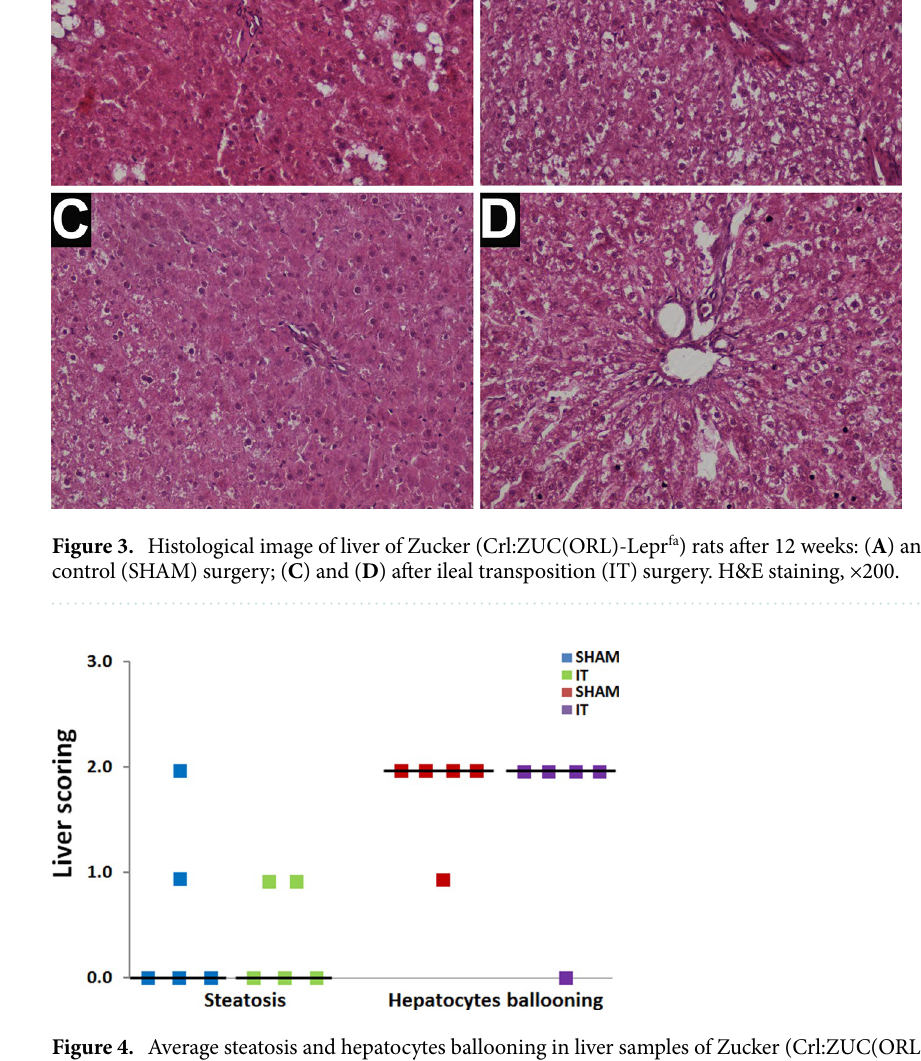
Figure 4. Average steatosis and hepatocytes ballooning in liver samples of Zucker (Crl:ZUC(ORL)-Lepr fa ) rats 12 weeks after control (SHAM) surgery or ileal transposition (IT). Results are presented as average scoring ± SEM (standard error of measurement) (n =